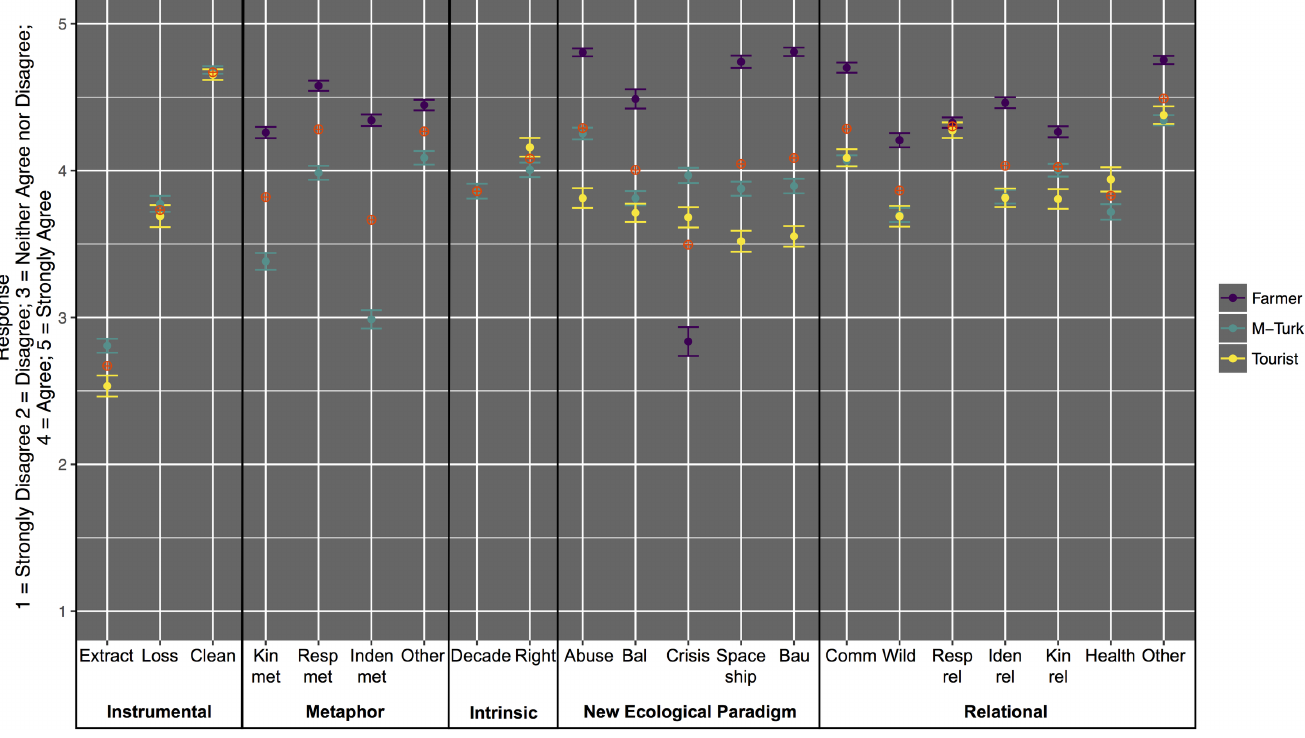
Fig 3. Mean response with standard errors to value prompts across three populations. Red circles indicate the mean responseacross the populationsfor each value statement.